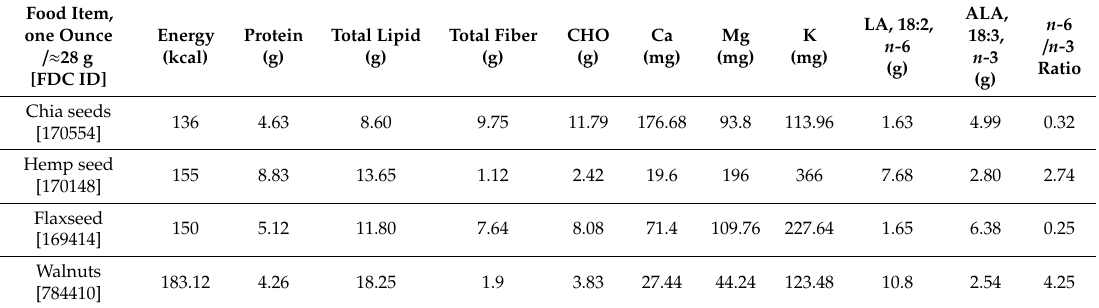
Table 1. Nutrition facts of ALA-containing